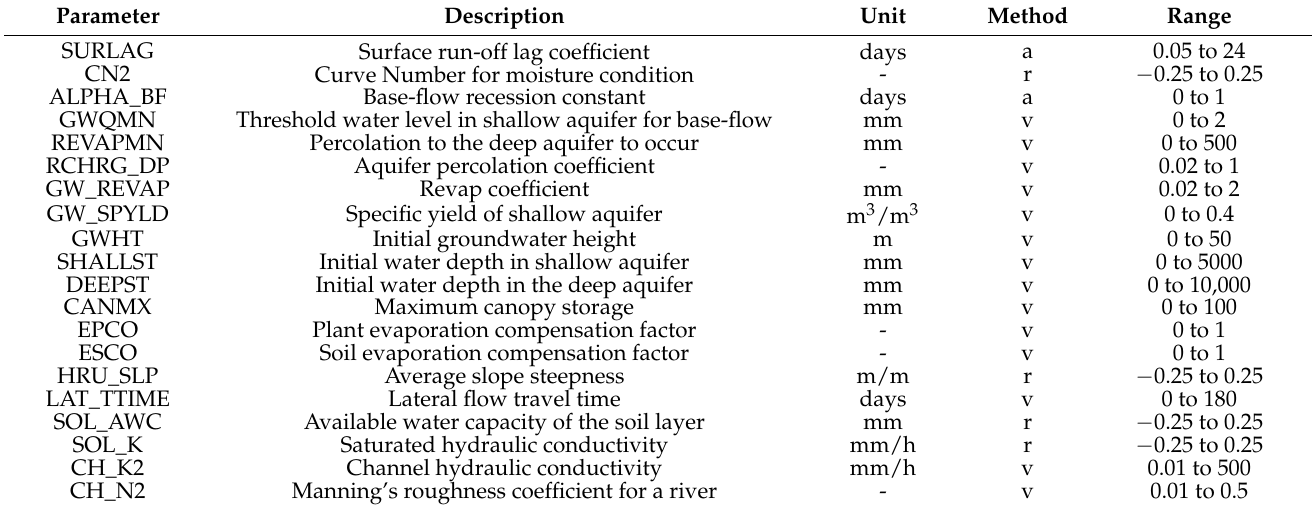
Table 1. Parameters used in streamflow